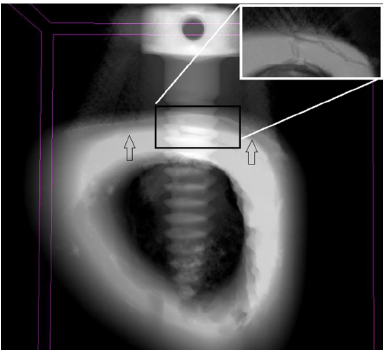
Figure 5. Dependence of the surface area on length.